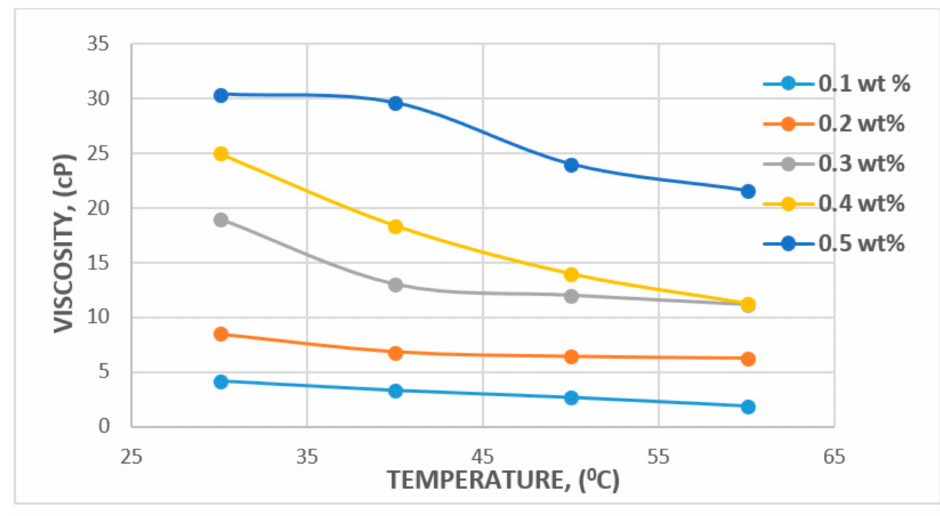
Figure 16. E ff ect of temperature on XG. Reprinted and modified from [26]. Table 1. Select reported literature on temperature and salinity for XG and HPAM